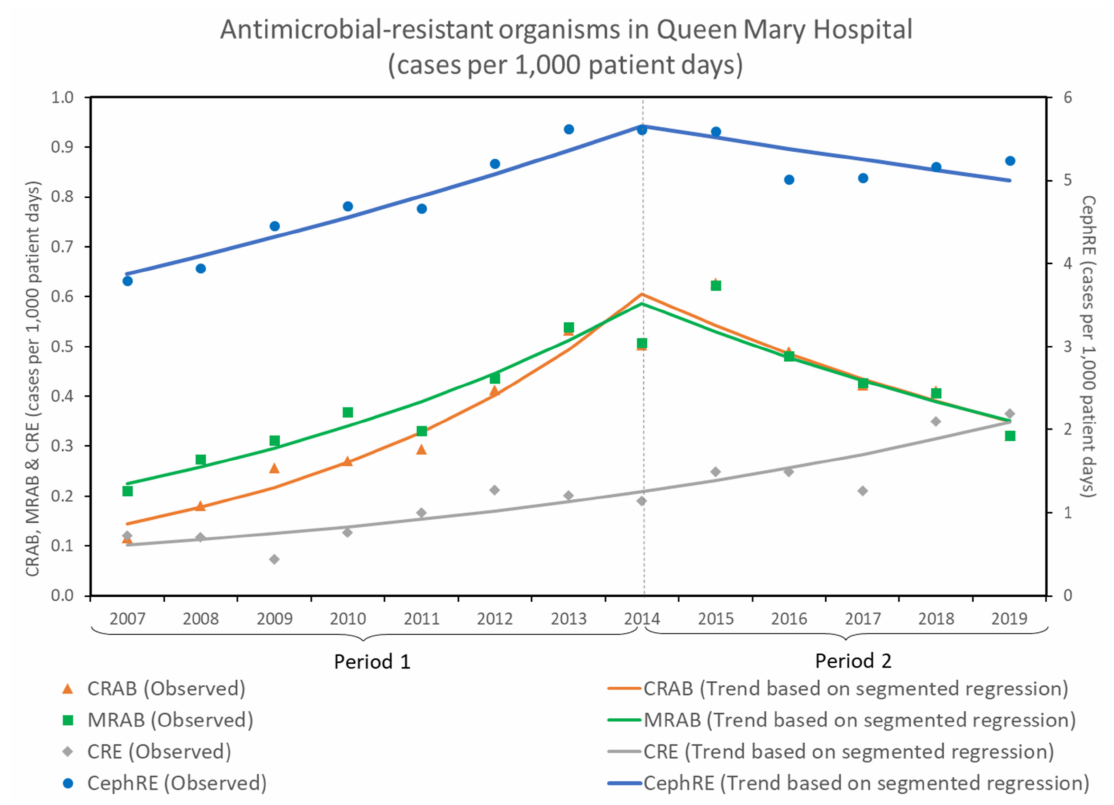
Figure 1. Antimicrobial-resistant organisms in Queen Mary Hospital from 2007 to 2019.